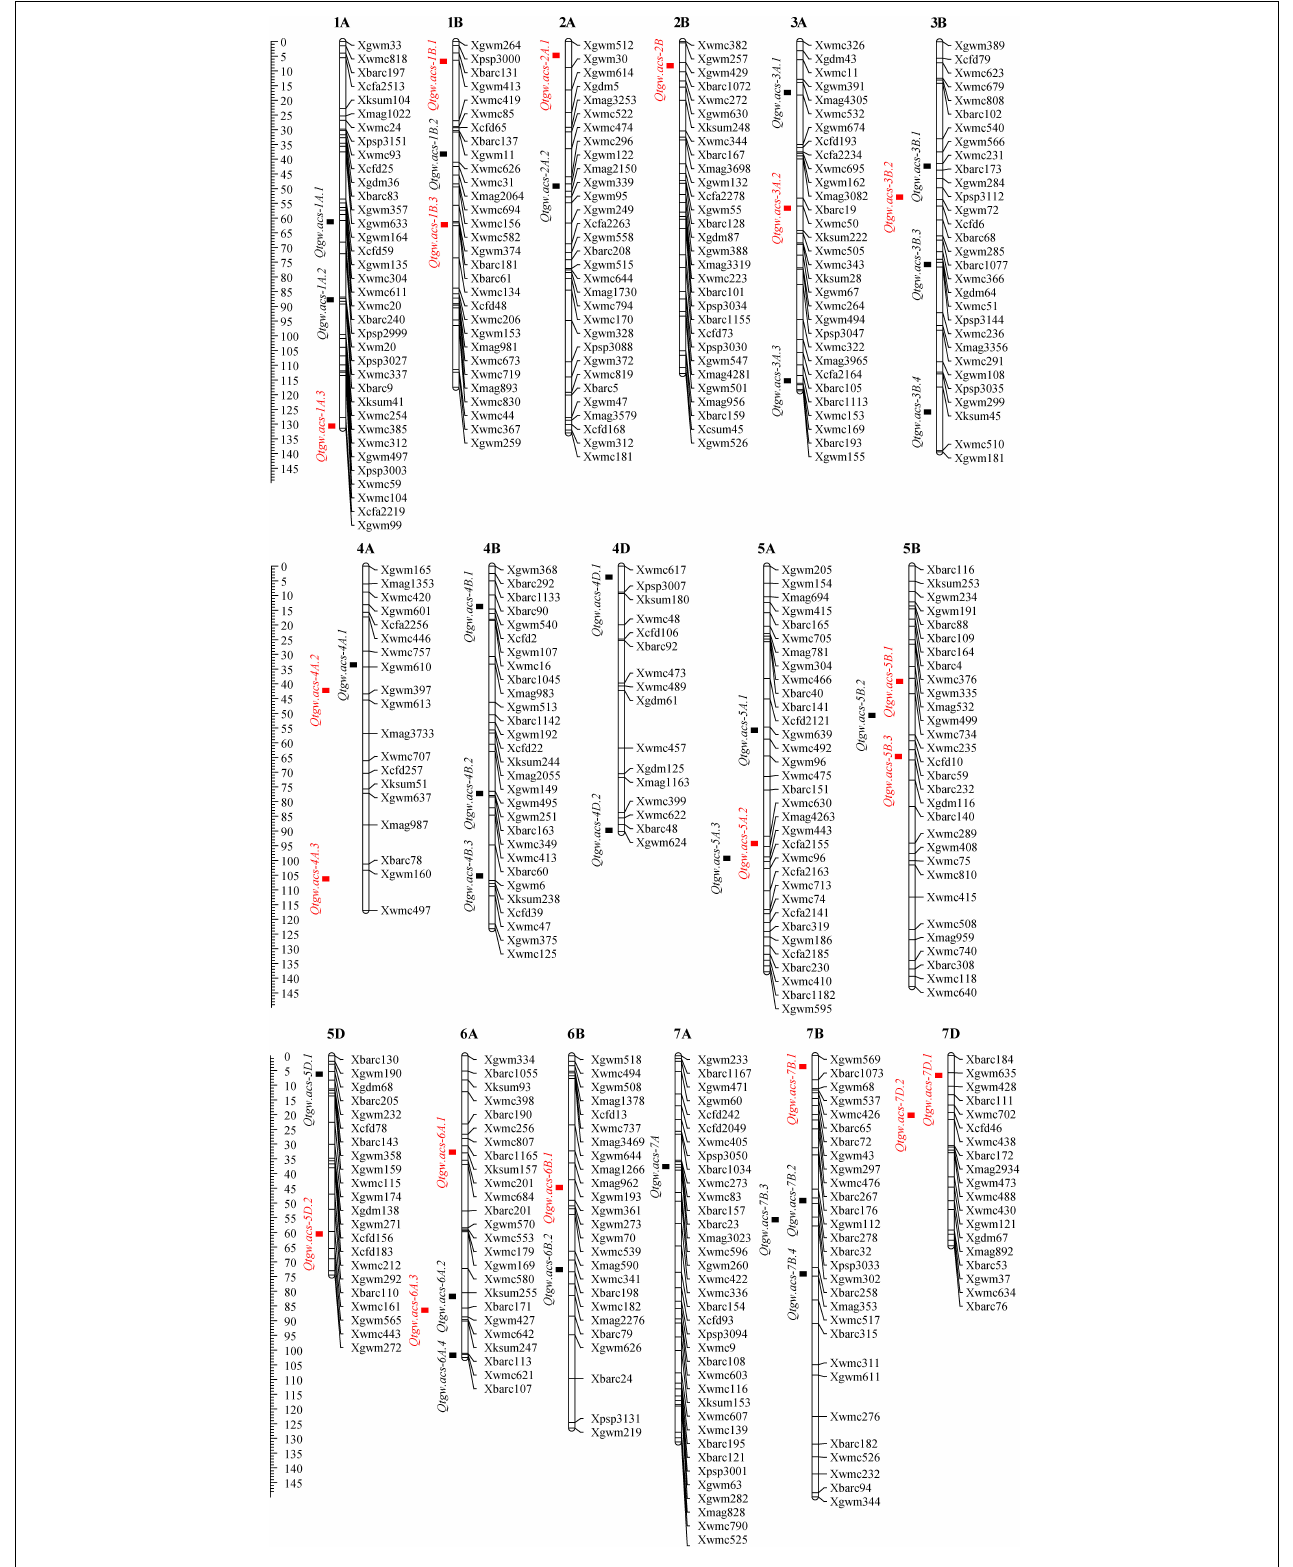
FIGURE 2 | Genetic map with additive QTLs for TGW under eight tested environments and BLUP analysis. The squares represent the locations of QTLs. The black squares are QTLs expressed only in one environment and red squares are expressed repeatedly in at least two environments.